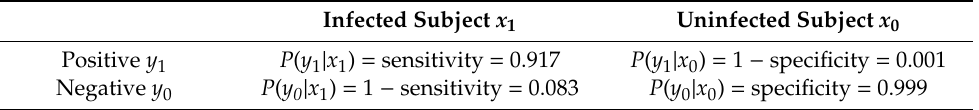
Table 1. The sensitivity and Specificity of a Medical Test ascertain a Shannon Channel P ( Y | X ).